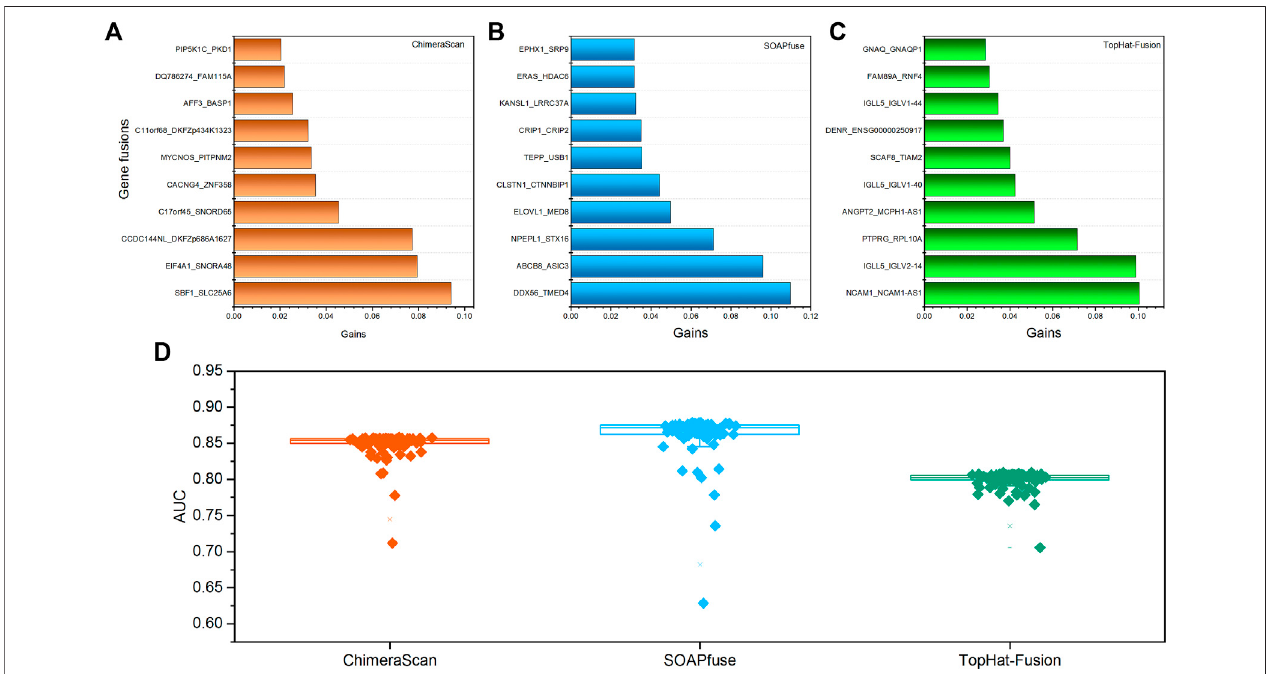
FIGURE 4 | The top 10 important gene fusions and performance of the XGboost classi fi er for rede fi ned high-risk patient subgroup: (A – C) the top 10 gene fusions extracted from XGboost model for ChimeraScan, SOAPfuse, and TopHat-Fusion, respectively; (D) the average AUC of 100-run 5-fold cross-validations (CVs) of the XGBoost model.